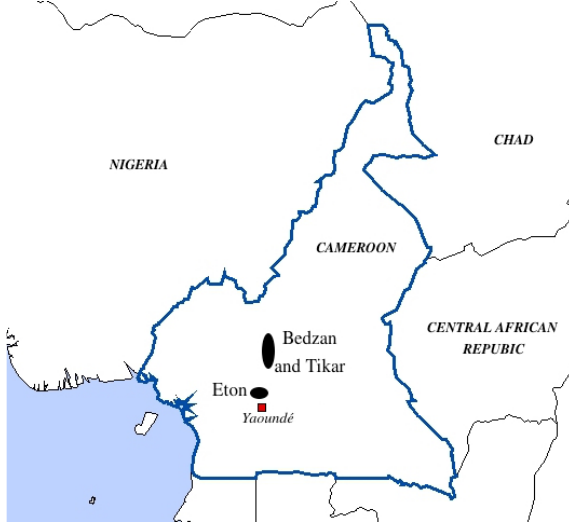
Figure 1. Map of Cameroon and localization of the three ethnic groups involved in this study. Adapted from